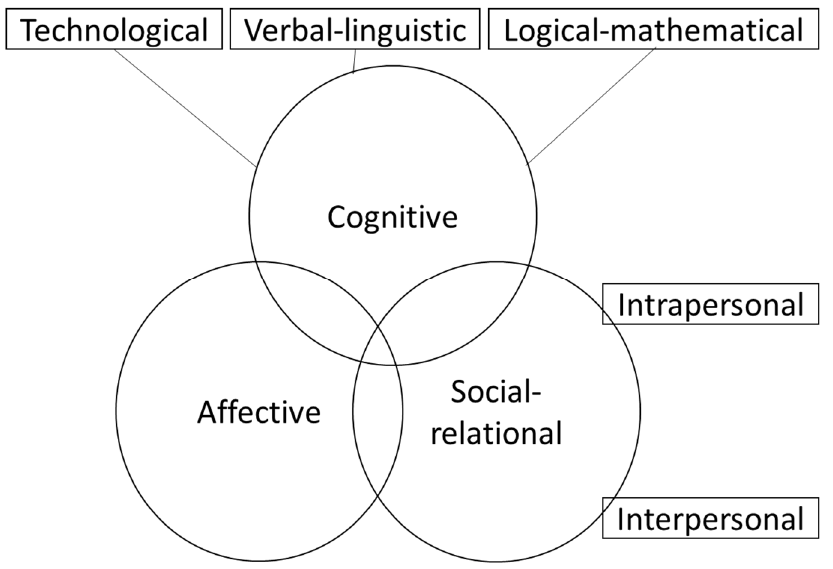
Figure 1. Digital literacy framework, adapted from Cartelli 2010.